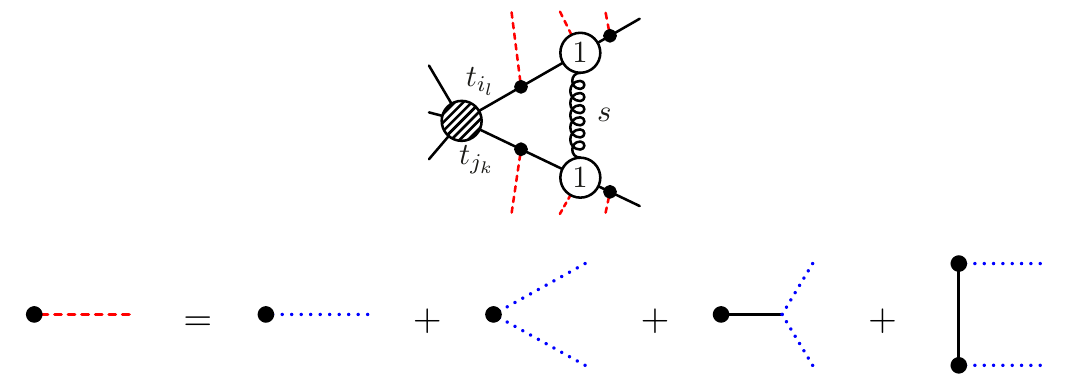
(1) (1) or along collinear YM (cid:24) L L